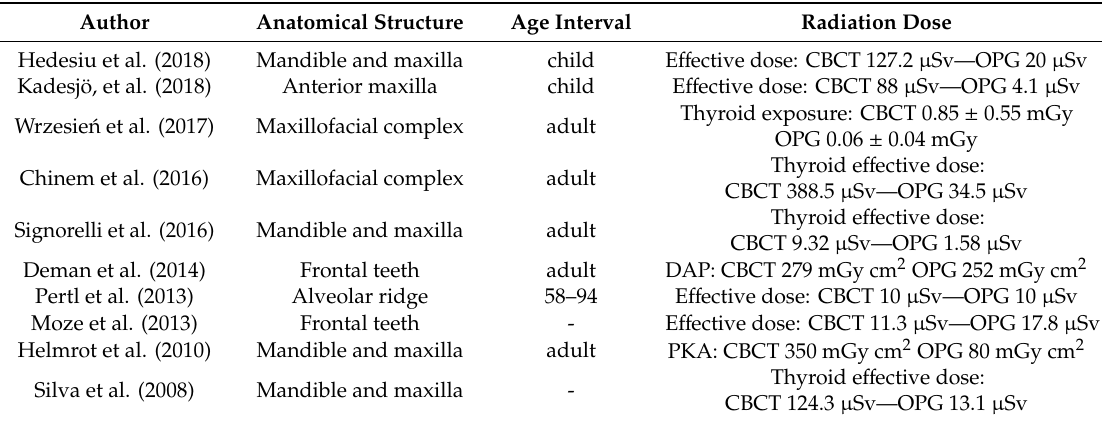
Table 6. Summary of data regarding radiation dose